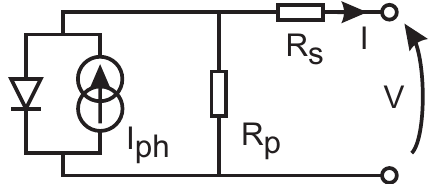
Figure 10. One-diode equivalent circuit of a PV cell.